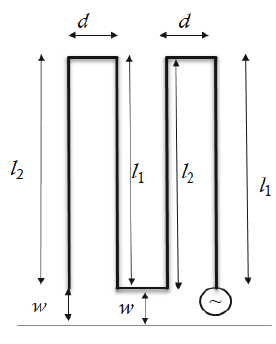
Figure 2. The parameters of the two-fold (TF) monopole.